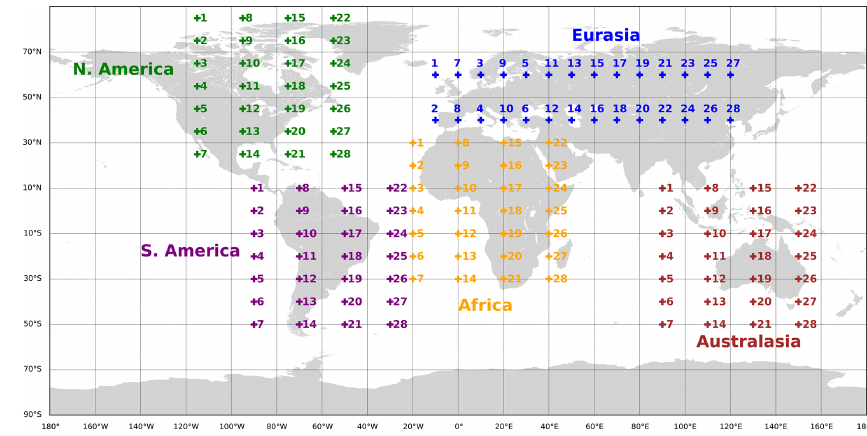
Figure 1. Numbered NO x point source emissions by region. Emission point coordinates are included in Appendix A.